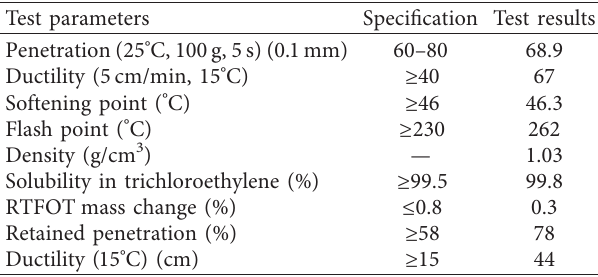
Table 1: Basic properties of penetration grade 70# base asphalt used herein. Test parameters